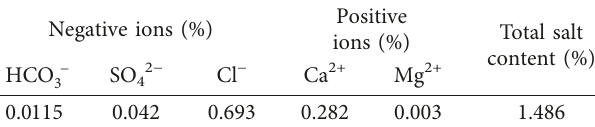
Table 2: Soluble salt content in soil.